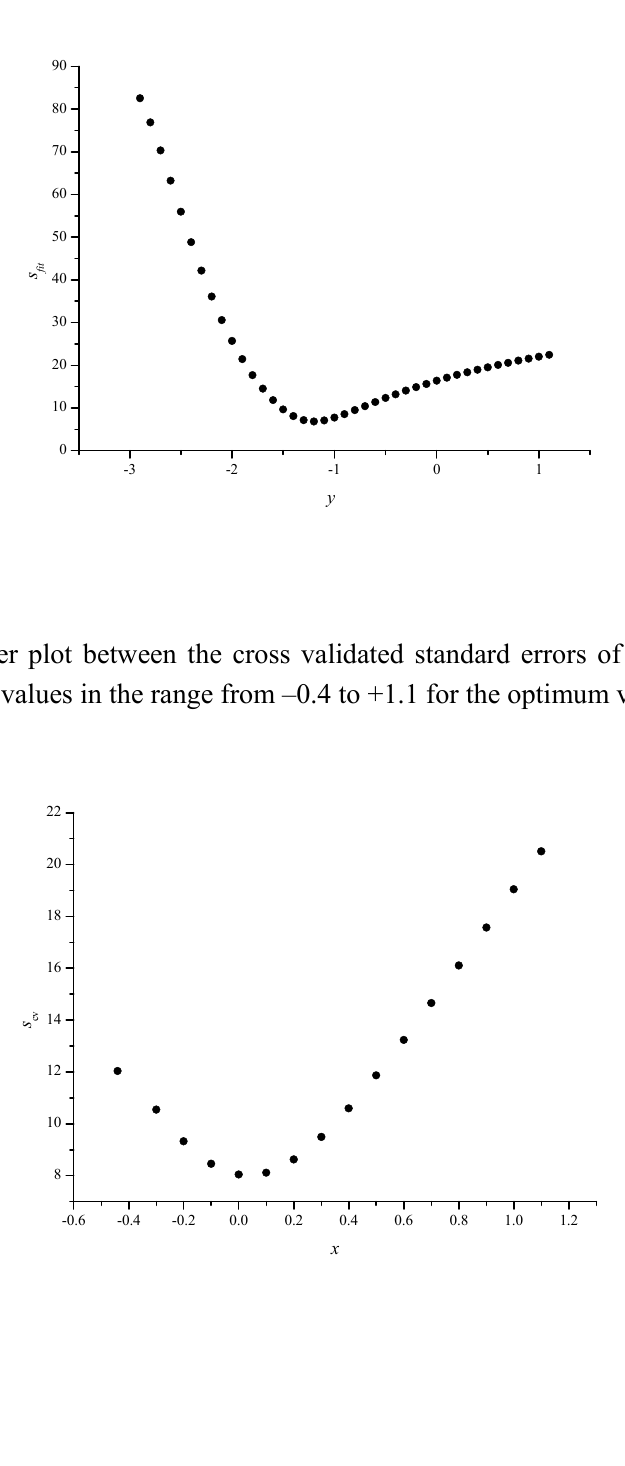
Figure 4. Scatter plot between the fit standard error of estimate ( S the range from –3 to +1.1 for the optimum value of x (0.0)